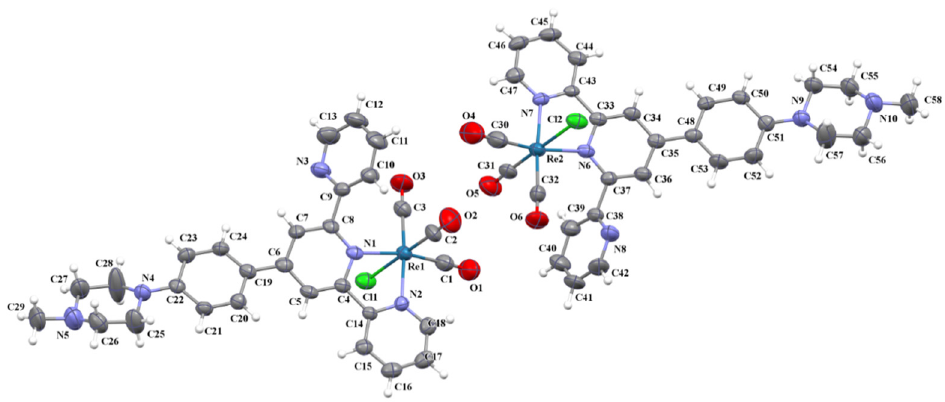
Figure 1. The asymmetric unit of 1 with the atom numbering and thermal ellipsoids set at 50% probability for non-hydrogen atoms. Selected bond lengths (Å) and angles ( ◦ ) associated with the Re(1) ion: Re(1)–N(1) 2.205(4), Re(1)–N(2) 2.171(4), Re(1)–C(1) 1.893(6), Re(1)–C(2) 1.926(6), Re(1)–C(3)